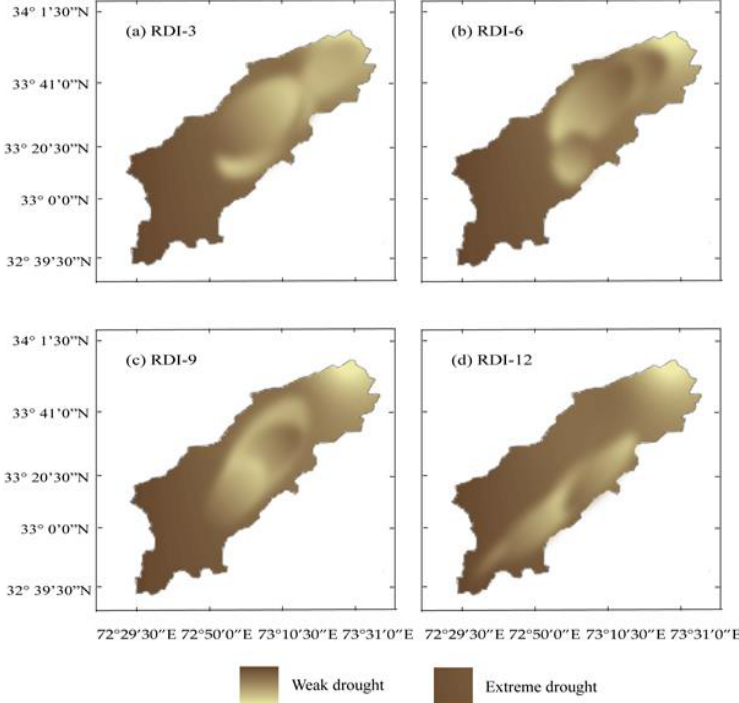
Figure 3. ( a – d ), Spatial variations of RDI-3 , -6, -9 , and -12 , respectively, for an extreme drought year.